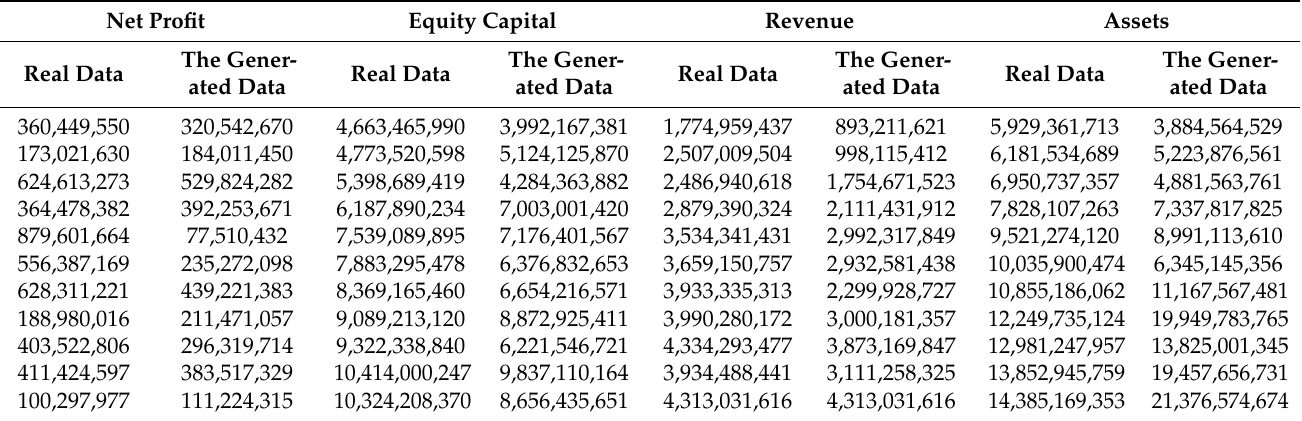
Table 3. Conformity assessment experienced and generated by the method of statistical tests the original